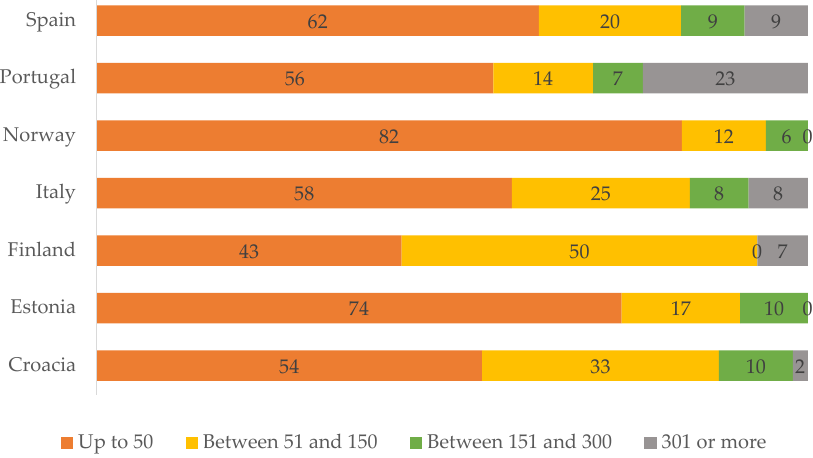
Figure 4. Relative distribution of number of honeybee colonies by country (%).